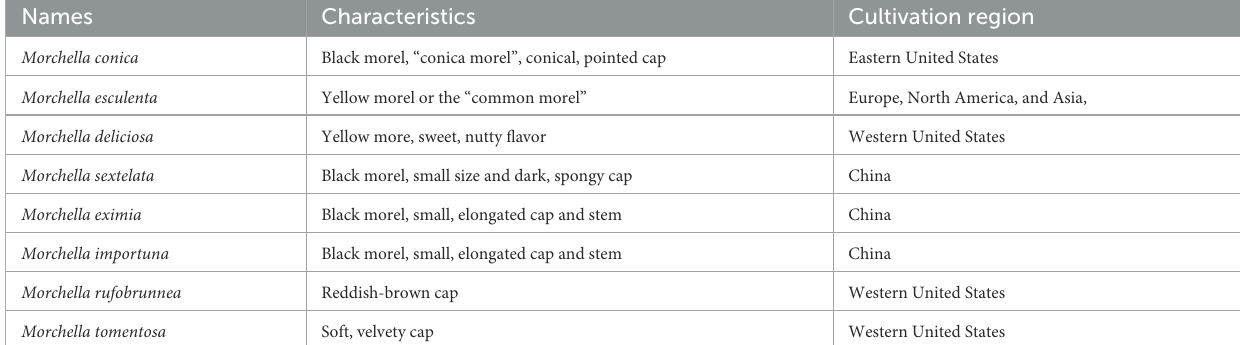
TABLE 1 Common morel species under